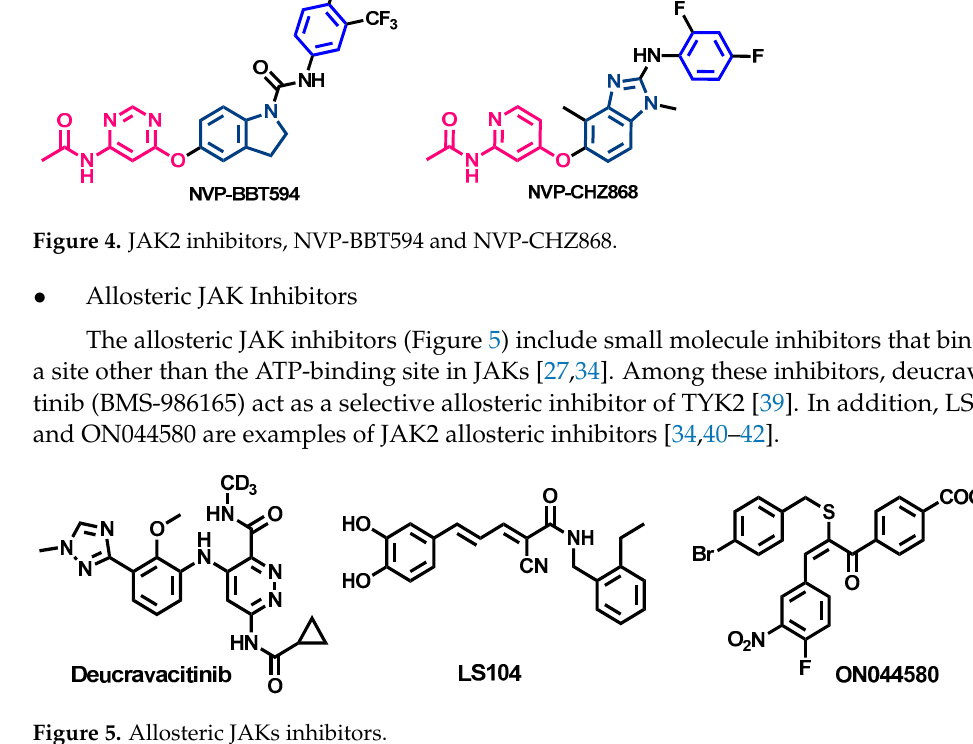
Figure 6. JAK3 covalent inhibitors. Compound 1 was reported among a series of cyanamide-based JAK3 covalent inhib- itors [43]. Moreover, compounds 2 (IC 50 = 0.003 μ M) and 3 (IC 50 = 154 pM) were also re- ported with potent and selective inhibitory activity against JAK3 [44,45]. Ritlecitinib (Figure 6) is an irreversible inhibitor of JAK3, which is currently under evaluation in clinical trials in humans [43,46]. The inhibitory activity of ritlecitinib was mediated by a covalent interaction with Cys909 residue in JAK3 [43]. The binding mode and interaction of ritlecitinib in JAK3 (pdb: 5TOZ) are visualized in Figure 7. The crystal structure was downloaded from the protein data bank (https://www.rcsb.org/, accessed on 11 November, 2021). In this work, the crystal structures of JAK kinases were visualized using the Discovery Studio Visualizer [47]. The crystals were prepared by removing water molecules following the previous reports [48,49]. Moreover, 2/3D binding modes of the